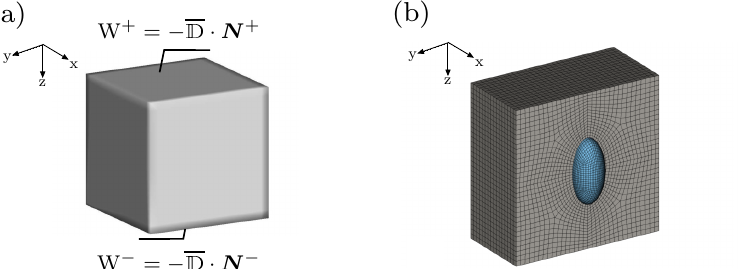
Figure 4. ( a ) Schematic representation of the structure with applied surface charge density W, ( b ) finite element mesh of the structure showing one-half of the soft matrix and the full inclusion with a volume fraction f = 1% and an aspect ratio r = 2 [ − ]